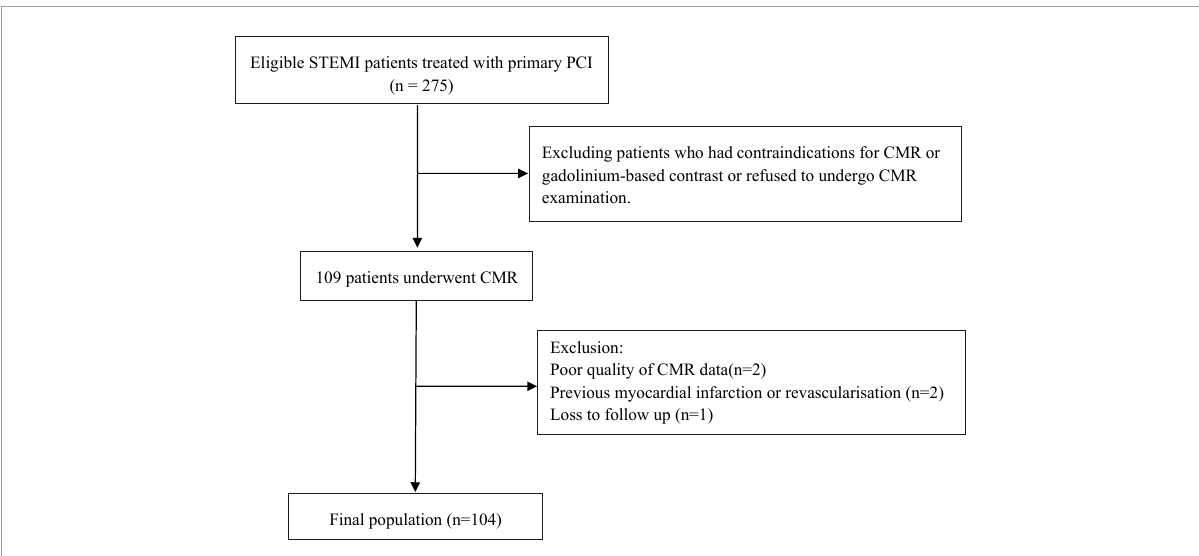
FIGURE1 Study flow chart. STEMI, ST-segment elevation myocardial infarction; PCI, percutaneous coronary intervention; CMR, cardiovascular magnetic resonance.